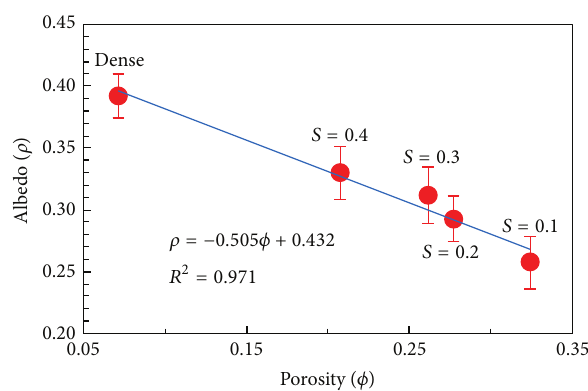
Figure 4: The albedo of pervious concrete with different porosity.